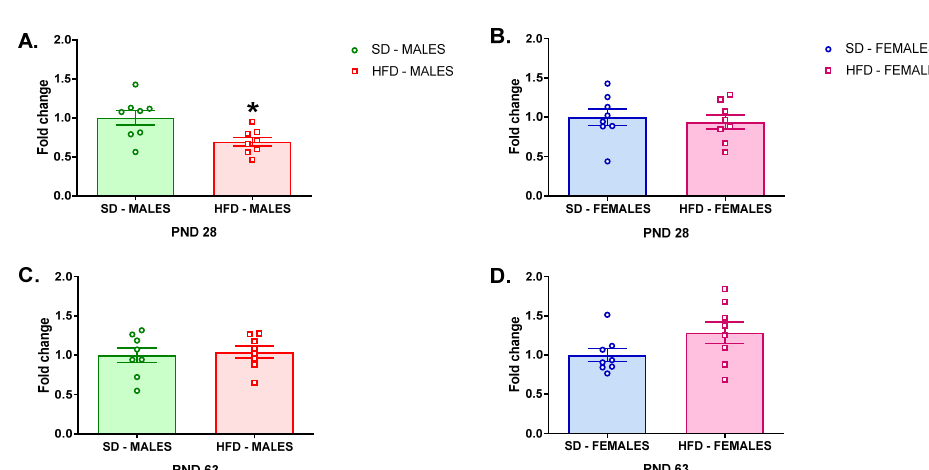
Figure 2. Changes in the Cnr1 mRNA level in the DSTR of adolescent ( A ) male and ( B ) female offspring or young adult ( C ) male and ( D ) female offspring whose mothers were fed on an SD or HFD during pregnancy and lactation. DSTR—dorsal striatum; HFD—high-fat diet; PND—postnatal day; SD—standard diet. Data are presented as the mean ± SEM with individual value plots. N = 8 rats/group. * p < 0.05 vs.